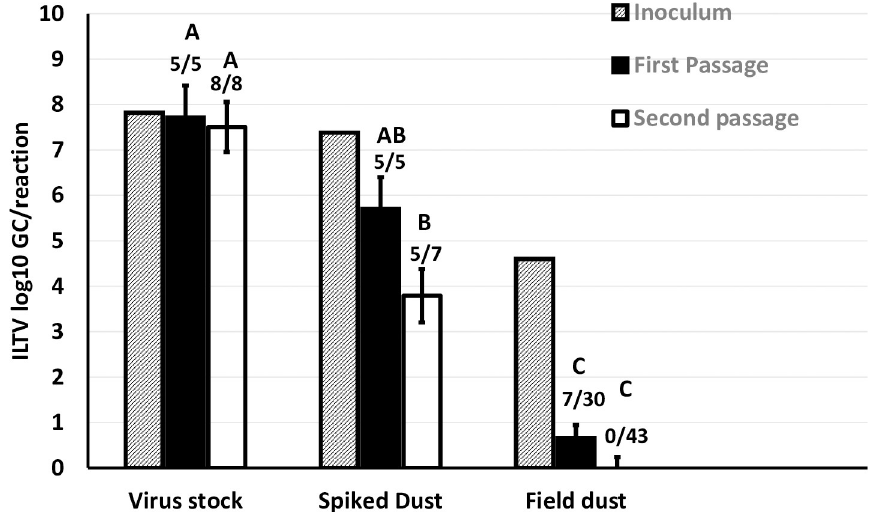
Fig 1. Experiment EGG-1. ILTV log 10 GC (LSM ± SE) in the inoculum and allantoic fluid of embryonated eggs inoculated with dust samples naturally ILTV log 10 GC positive, spiked dust and ILTV stock propagated in cell culture after the first and second passage. Number of positive samples and total number of samples are also given. Superscripts (ABC) not sharing the same letter denote difference (p < 0.05) between samples.